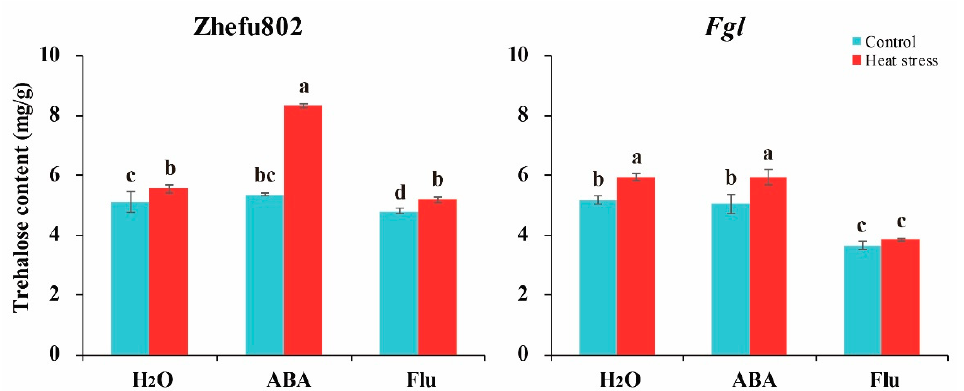
Figure 3. The effects of exogenously applied ABA on trehalose content of rice plants under heat stress. ABA, abscisic acid. Flu, the ABA synthase inhibitor fluridone. Error bars denote standard deviations ( n = 3). Different letters indicate significant differences between the control and heat stress treatments within a genotype by two-way analysis of variance (temperature and treatment) ( p < 0.05).